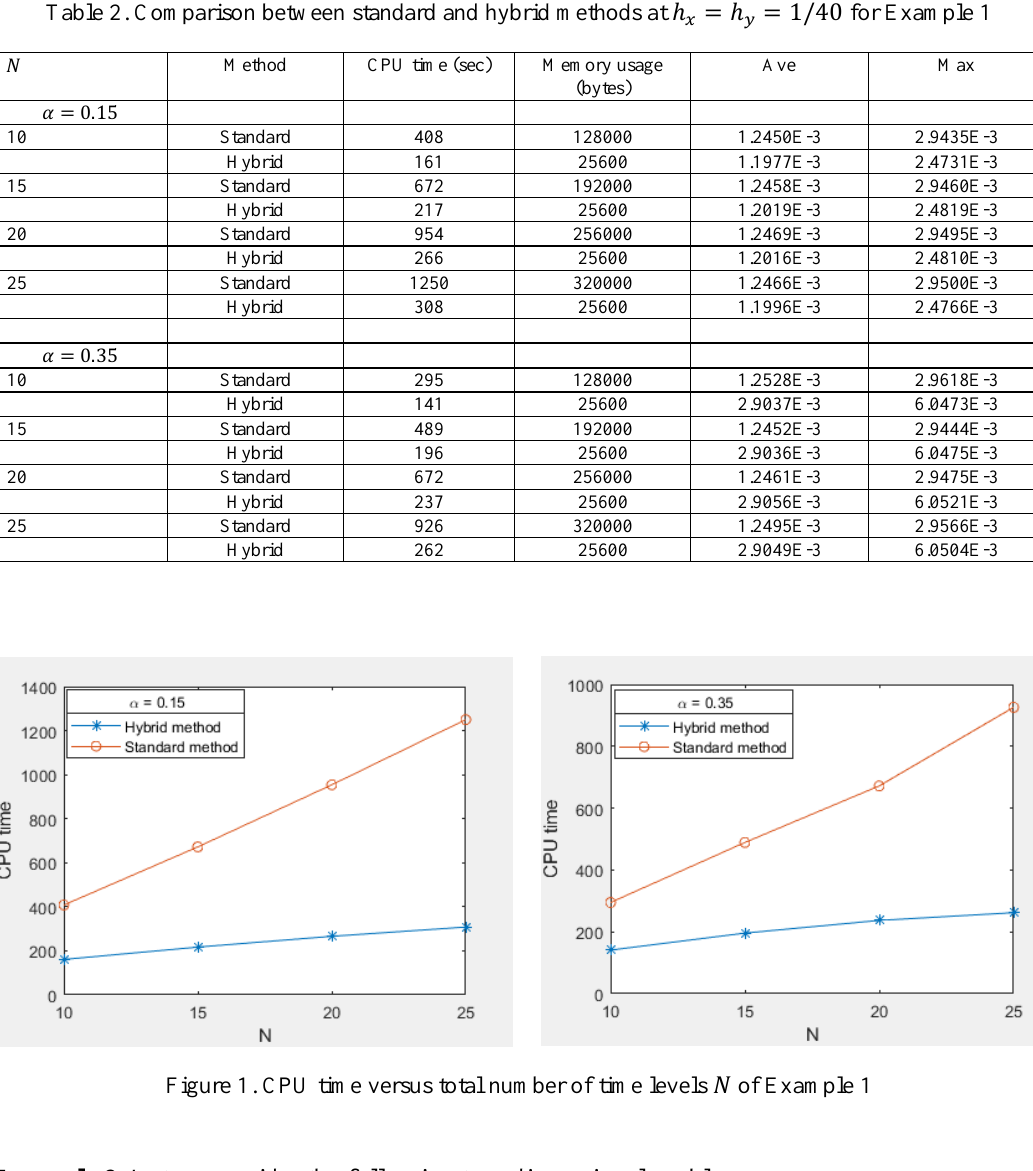
Table 2. Comparison between standard and hybrid methods at ℎ